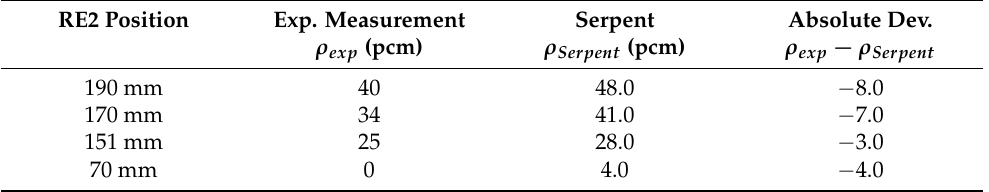
Table 4. Reactivity values and deviation in pcm from Serpent calculations and experimental data.